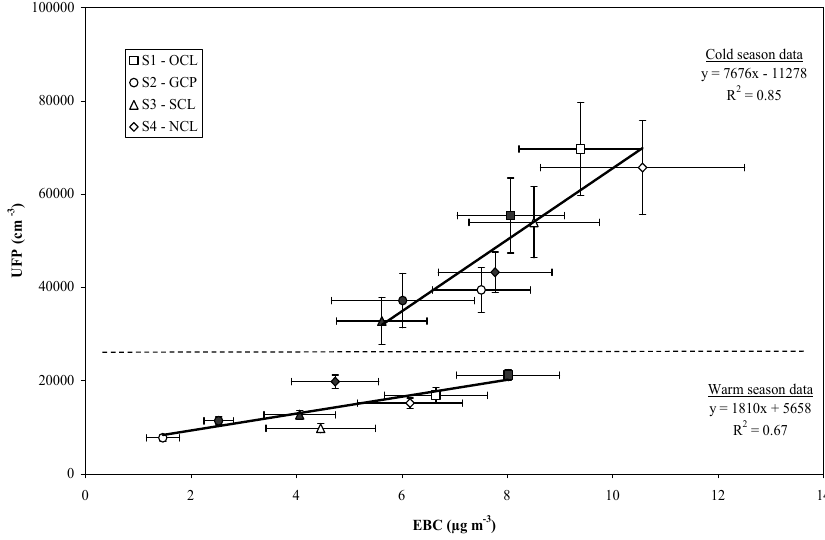
Figure 7. Scatter plot for sector-related EBC and UFP concentration levels (mean and 95% confidence intervals for the mean). Dark symbols: morning data; white symbols: evening data.